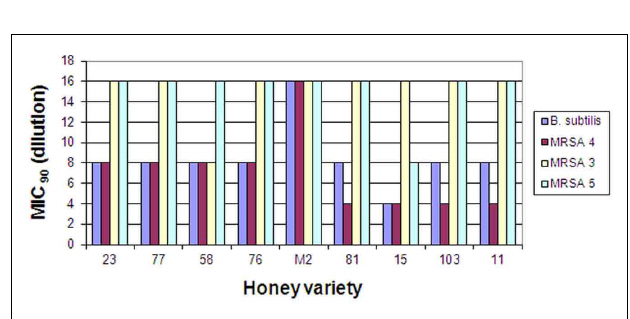
FIGURE 2 | Bacteriostatic activity of eleven honey varieties against two clinical isolates of methicillin-resistant Staphylococcus aureus strains, MRSA 3, 4, and 5. Reproducibility for each strain was determined at minimum in three separate experiments conducted in